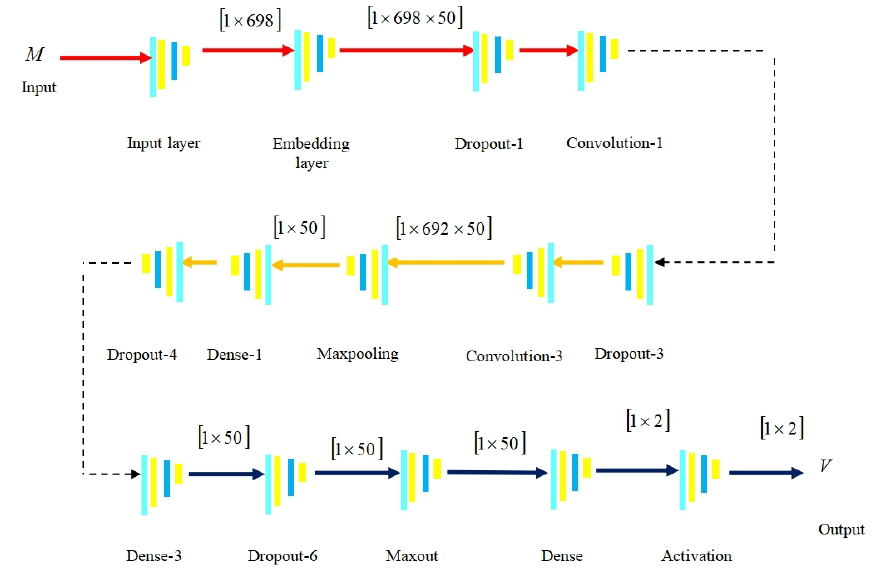
Figure 4. Structure of Deep maxout